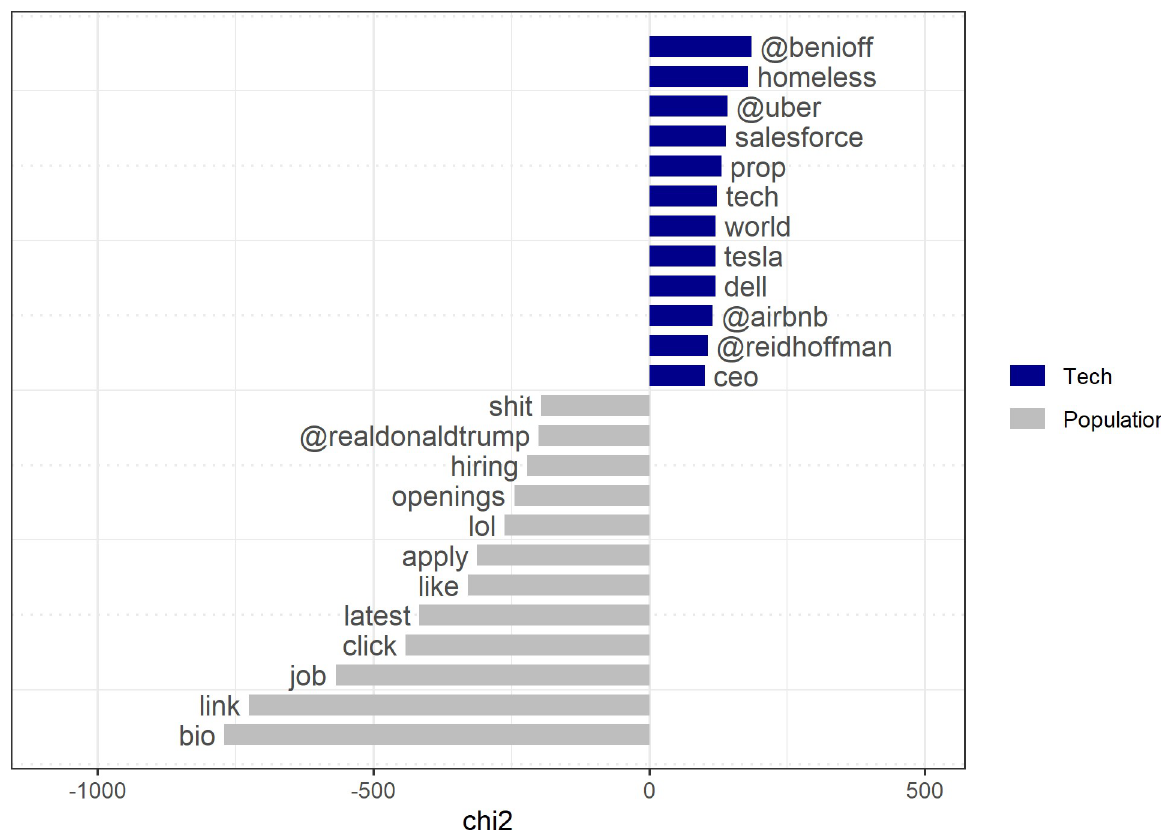
Fig 6. Keyness statistics for tweets with “achieve” and related